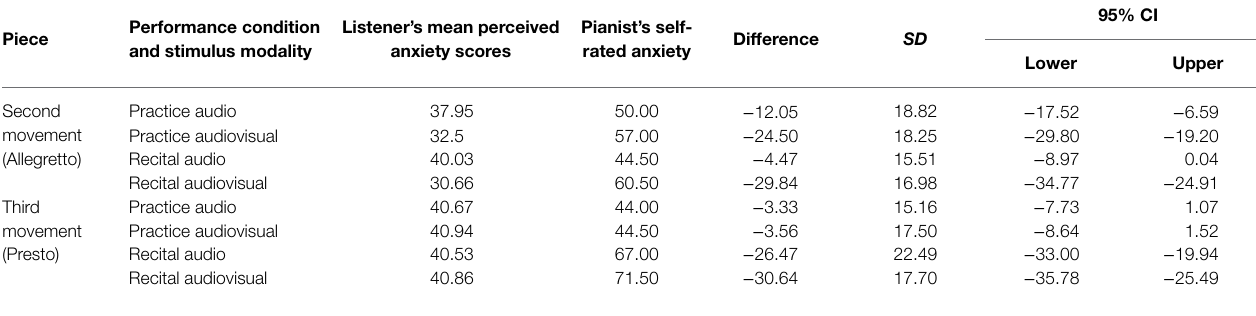
TABLE 3 | Listener’s mean perceived anxiety scores and musician’s self-rated anxiety.